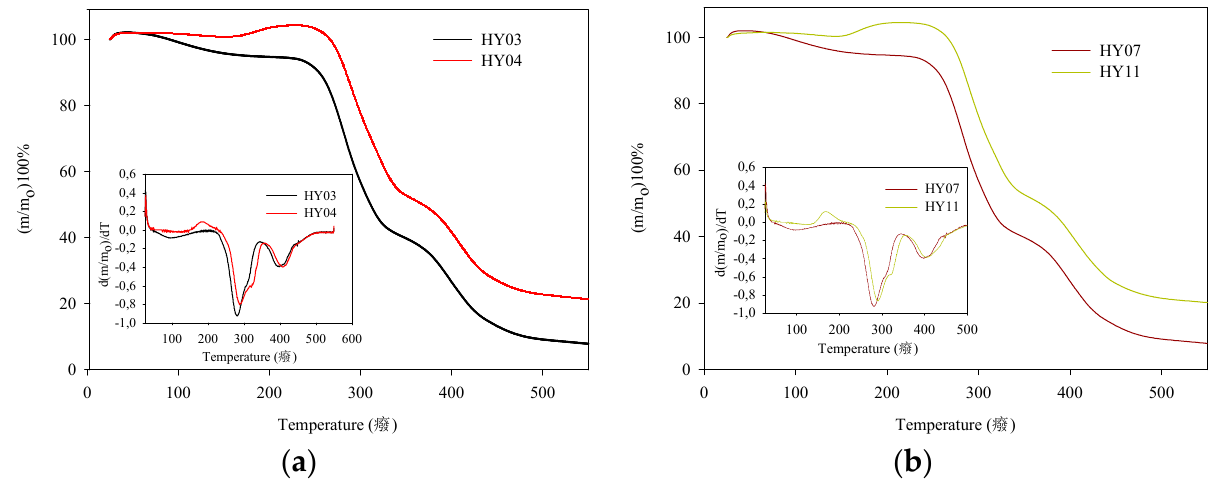
Figure 5. Thermogravimetric analysis TGA of the samples: ( a ) Hy03 and Hy04, ( b ) Hy07 and Hy11. Upon analysis of Hy03, which did not contain CNF, a decomposition was observed from 248.0 ◦ C to 330.0 ◦ C, resulting in a residual mass percentage of 45.1%; in the second stage, a residual mass percentage of 18.4% was obtained with respect to the initial